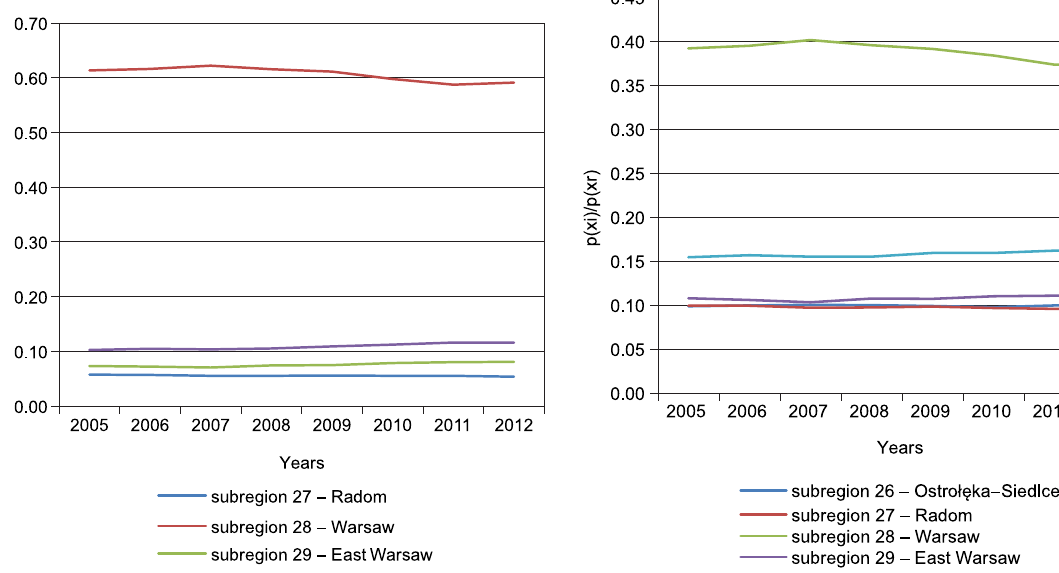
Fig. 5. Internal differences in Mazovia on the basis of the probability of per capita income in the years